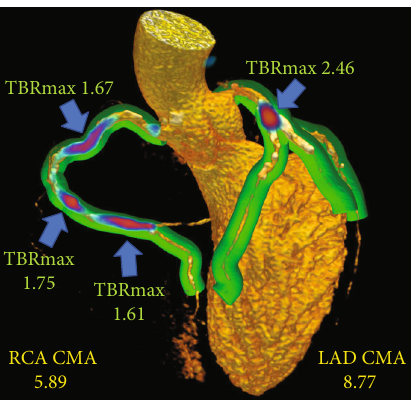
Figure 2: 3-dimensional rendering of coronary CT angiography with superimposed tubular whole-vessel volumes of interest (light green) employed for evaluation of 18 F-sodium fl uoride uptake (blue and red). Despite the relatively lower tissue-to-background ratio maximum (TBRmax) due to multiple foci of increased 18 F- NaF activity, the coronary microcalci fi cation activity (CMA) in the right coronary artery (RCA) is only moderately lower than that in the left anterior descending (LAD) coronary artery which presented with a very high TBRmax. Reprinted by permission from Springer Nature: EJNMMI (Kwiecinski et al.